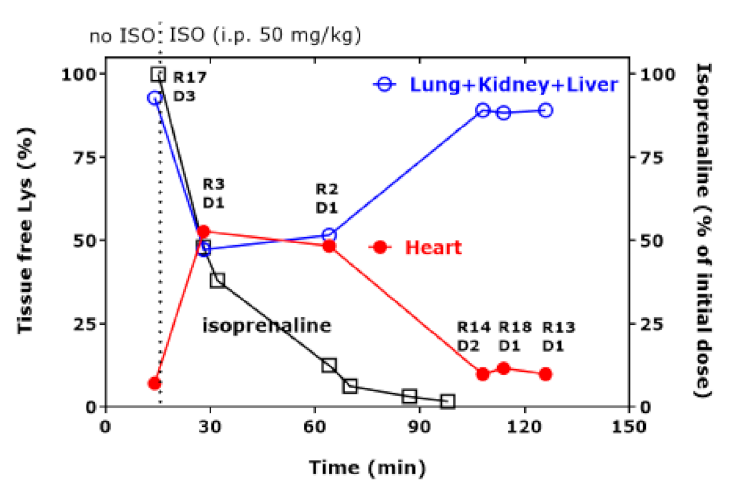
Figure 2. Tissue-free Lys percentage concentration in the heart and summed free Lys percentage concentration in lung, kidney, and liver of the indicated rats administered with the indicated hArg doses at t = 0 min and sacrificed at the indicated time points. The time course of percentage isopre- naline was calculated using an elimination half-life of 10 min [36]. D1, 20 mg/kg; D2, 220 mg/kg; D3, 440 mg/kg. R, rat; D, hArg